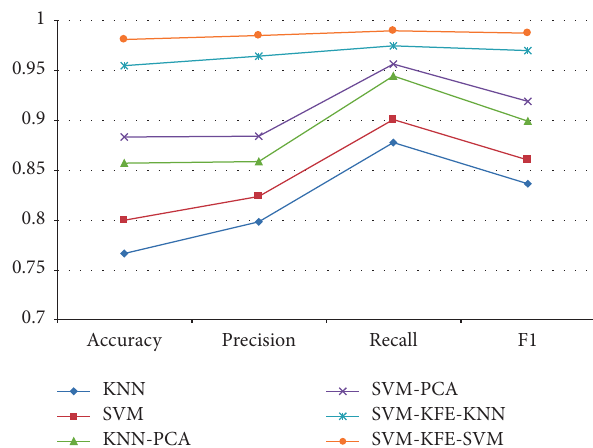
Figure 13: The comparison of algorithm performance when P ≤ 0 .